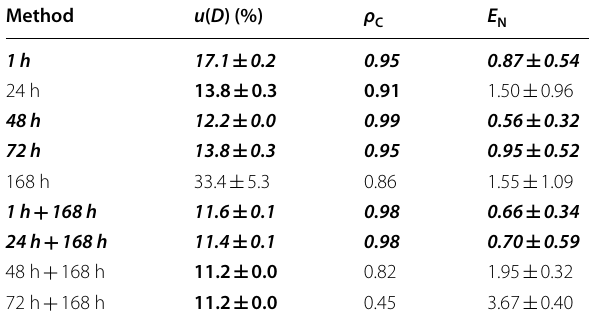
Table 4 The uncertainty u ( D ), Lin’s concordance correlation coefficient ρ for the simplified and the normalized error E N C dosimetry protocols for the salivary